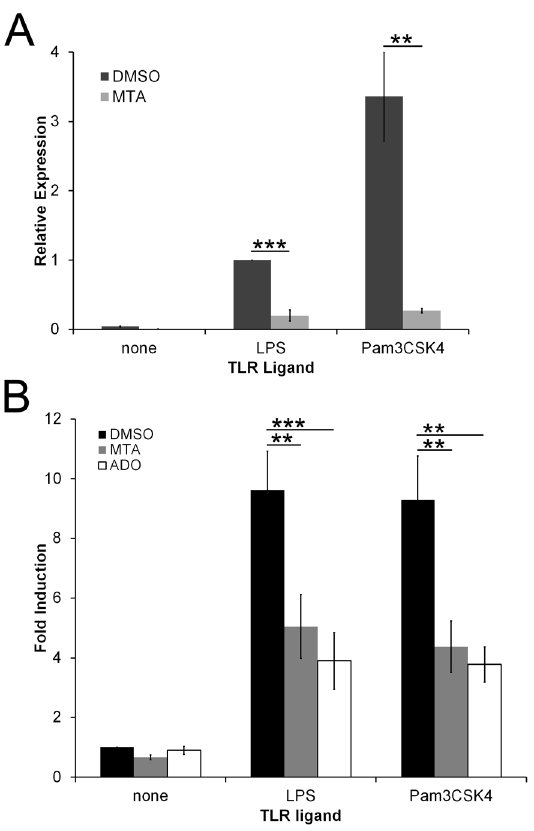
Figure 2. MTA inhibits TLR-induced TNF a mRNA production and NF-KB induction. (A) BMDM were incubated for 4 h with either DMSO or 200 m M MTA in the absence or presence of either 100 EU/mL LPS or 1 m g/mL Pam3CSK4. Total RNA was extracted from cells. TNF a expression relative to b -actin was determined by D ( D CT) method using real-time PCR. (B) RAW NF-KB reporter cells were treated with DMSO, 200 m M MTA or 200 m M adenosine (Ado) in the absence or presence of the indicated TLR ligands for 4 h at 37 u C. Supernatants were assayed for luciferase, which was normalized to DMSO-treated cells that received no TLR stimulation. The graphs represent mean 6 sem of 4 (A) or 5 (B) experiments. ** p , 0.01, *** p , 0.001.